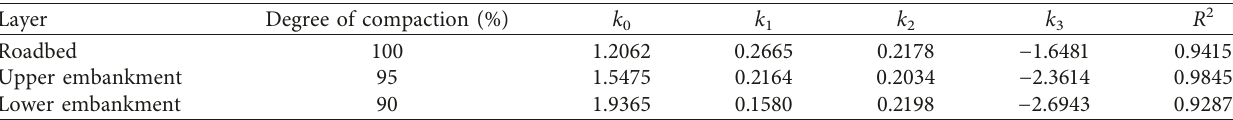
Figure 3: Flowchart of the user-defined material Table 2: Fitting parameters for Mr of subgrade soils.